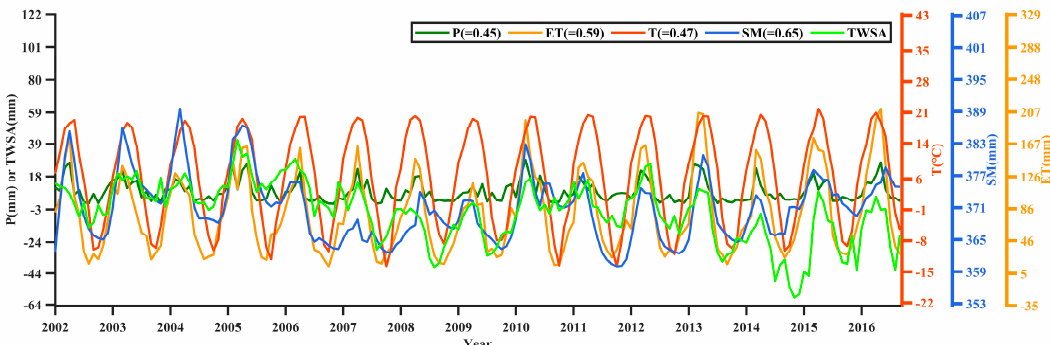
Figure 8. Correlations between precipitation (P), ET, temperature (T), and soil moisture (SM) with TWSA. The results in parentheses represent the correlation coefficients between hydrological data with TWSA from 2003 to 2012.